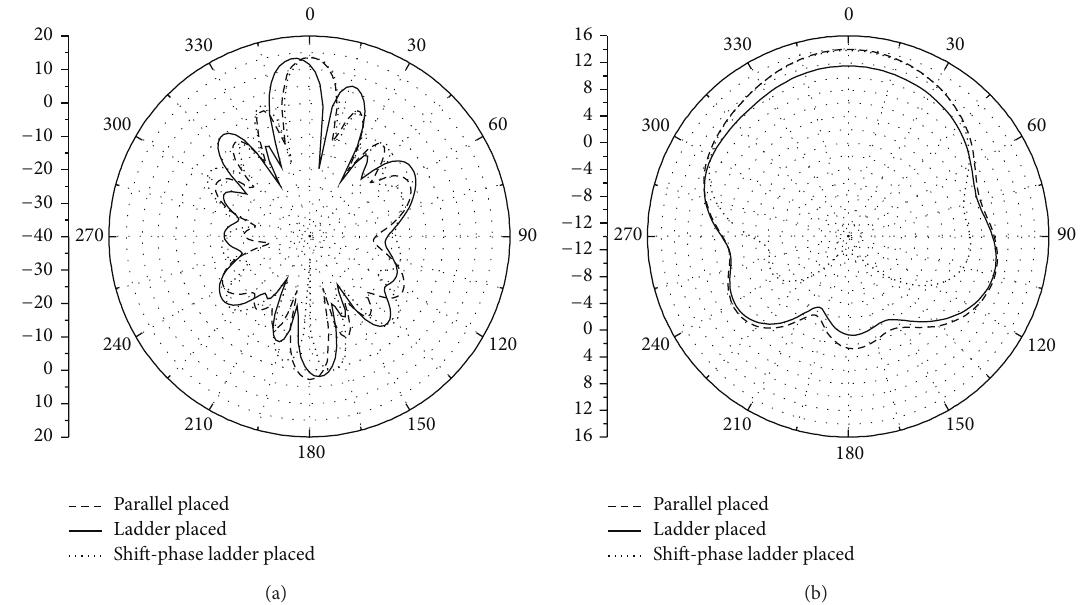
Figure 7: Pattern of 10GHz. (a) E-plane pattern of eight-element arrangement array. (b) H-plane pattern of eight-element arrangement.